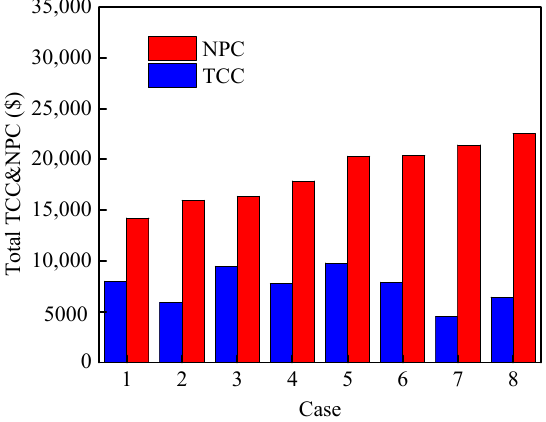
Figure 11. Computed generation profiles (1 kW wind turbine, PV and biogas genset): ( a ) power and ( b ) heat.